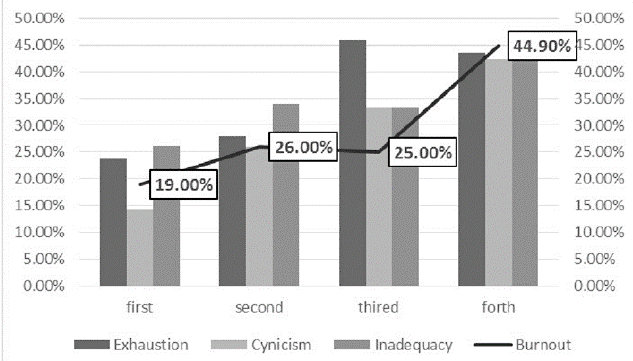
Figure 1. Influence of year of study on severe burnout (exhaustion, cynicism, and the feeling of